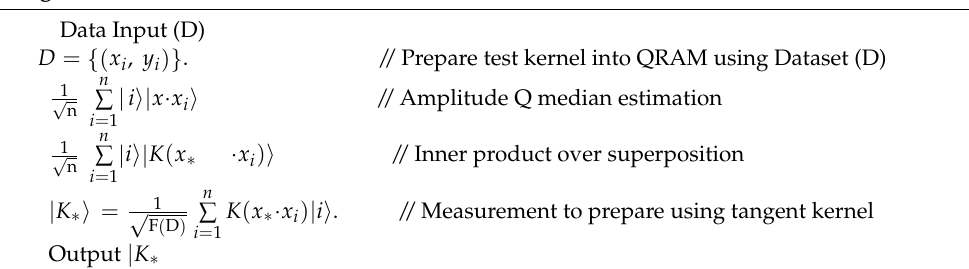
Algorithm 1. Quantum Variational